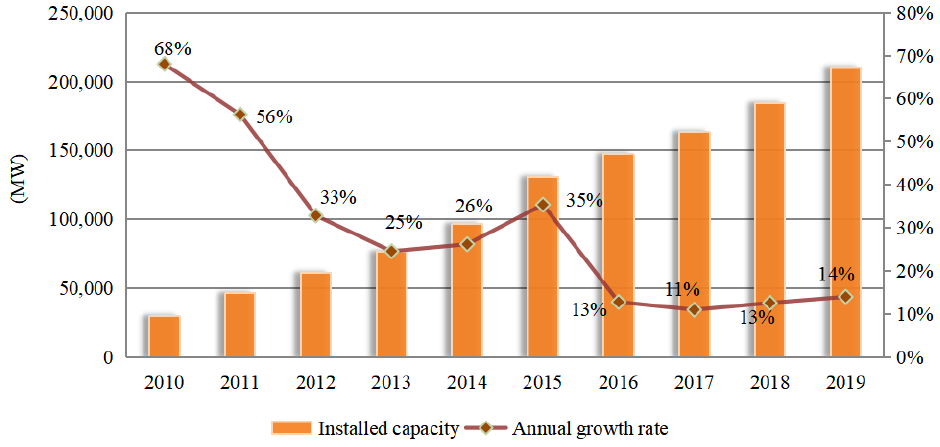
Figure 6. Cumulative installed capacity of China’s wind power in 2010– 2019.